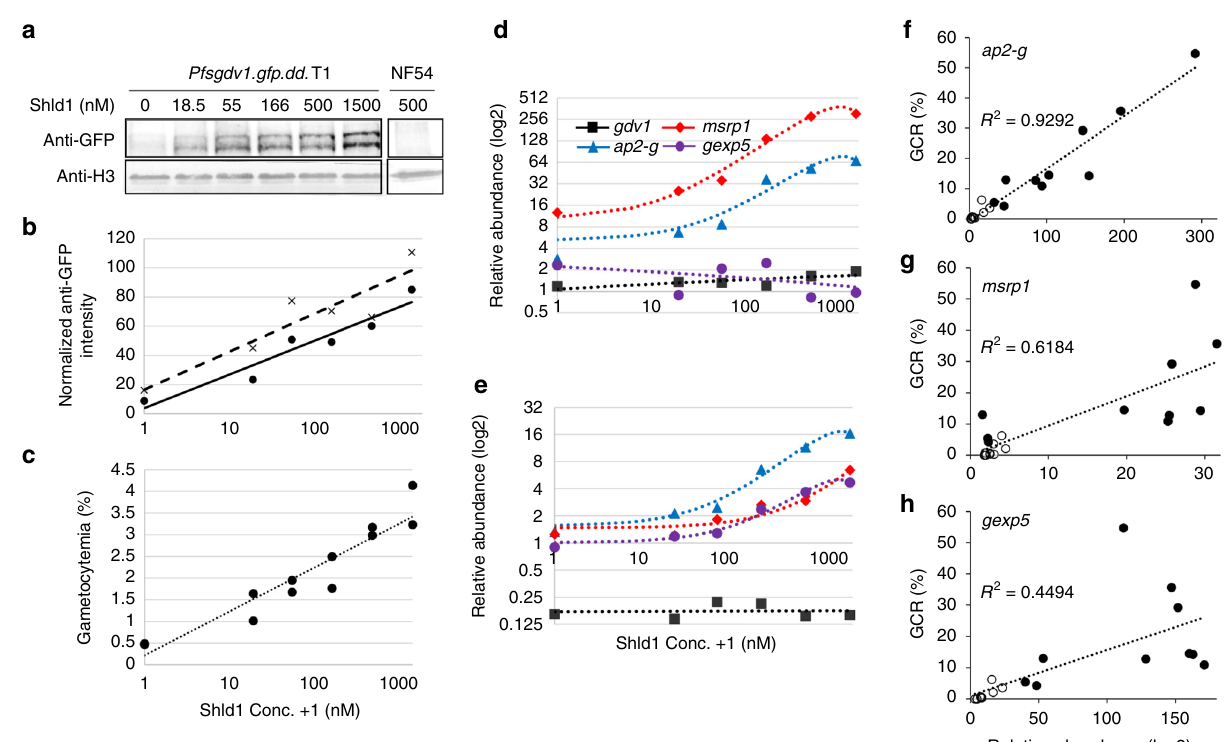
Fig. 9 Shld1 dose-dependent increase in GDV1 protein levels. a Immunoblot of saponin-treated Pfgdv1.gfp.dd or wild type NF54 schizonts extracted in 8 M urea/5% SDS after 24 h incubation in the indicated amount of Shld1. The immunoblot was fi rst probed with anti-GFP mAb and imaged, then reprobed with rabbit anti-Histone 3 (anti-H3) antibody as a loading control as described in Methods. The anti-GFP and anti-H3 positive bands are shown and the complete gel is shown in Supplementary Fig. 6A. b The density of the upper (dot) and lower (x) bands was determined after background subtraction using Image J software, normalized to the anti-histone 3 antibody signal and plotted. c – e Shld1 dose-dependent increase in gametocyte production and ap2-g , msrp1 & gexp5 transcription. c After growth in the indicated Shld1 concentration for ~50 h, NAG was added and gametocyte production (average± s.d.) was determined 9 days later by counting Giemsa-stained smears. d, e The average relative abundance (2 − ΔΔ C T ) of ap2 - g (blue), msrp1 (red), gexp5 (purple) and gdv1 (black) transcripts in RNA obtained from schizonts (46 ± 2 hpi) d and 14 h later from ring stage parasites ( e ) grown in the indicated concentration of Shld1 are plotted using early schizonts (36 ± 2 hpi) as the reference. The experiment was run twice with duplicate fl asks and a representative data set is shown with the trend lines indicated. The second experiment is shown in Supplementary Fig. 6B-D. f – h Gametocyte conversion rate is positively correlated with ap2 - g , msrp1 , gexp5 mRNA expression. The gametocyte conversion rate and the relative abundance (2 − ΔΔ C T ) of f ap2-g , g msrp1 or h gexp5 RNA in